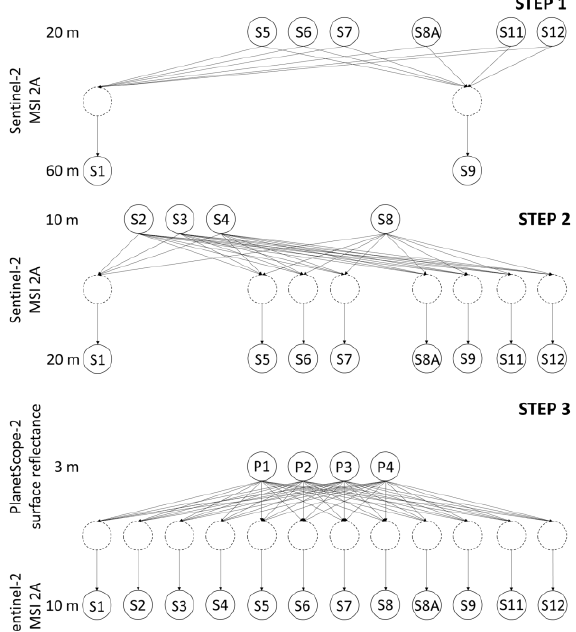
Figure 3 . Neural Network stepwise 12-band Sentinel-2 downscaling to PlanetScope-2 spatial